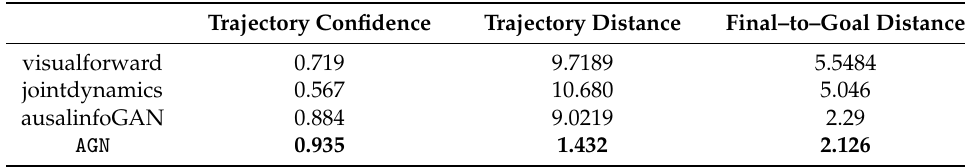
Figure 4. Result for rope manipulation data. The plot shows six planning instances, from left (initial observation) to the right (goal observation). Table 1. Evaluation of planning result in rope